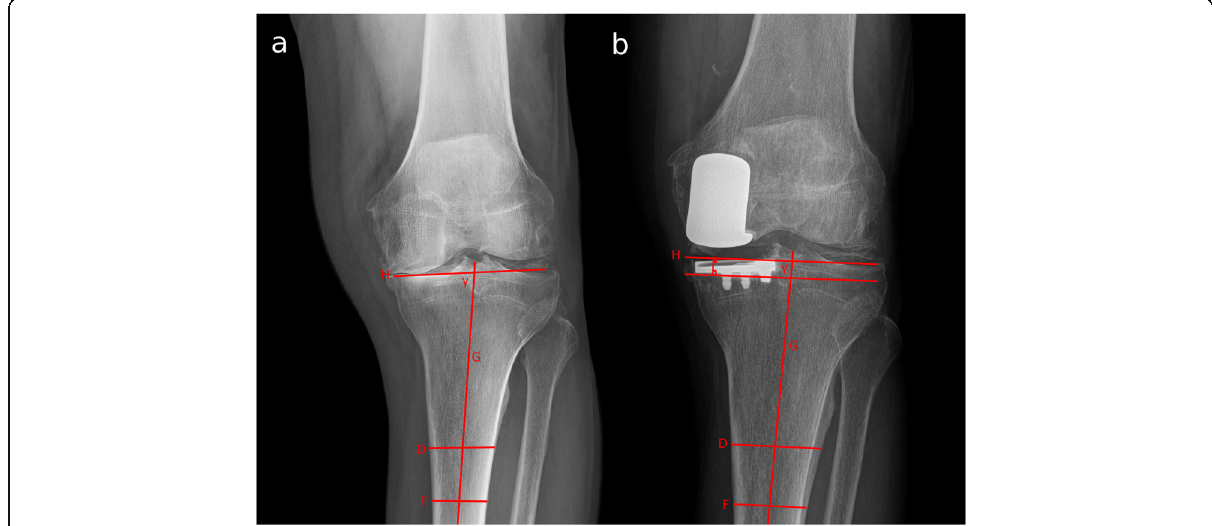
Fig. 3 Anteroposterior Knee X-rays of a left knee showing the tibial resection measure method. The angle (gamma) is obtained in the pre- operative x ray ( a ) between a line (H) that goes through both tibial plateaus and a line that represents the tibial anatomical axis (G), obtained by the center of two lines (D and F) at 7 and 10 cm distal to the joint line. Then the angle is reproduced in the post-operative x ray ( b ) with the tibial anatomical axis (G) and the non-operative tibial plateau. The distance from the line H to the base of the implant represents the tibial